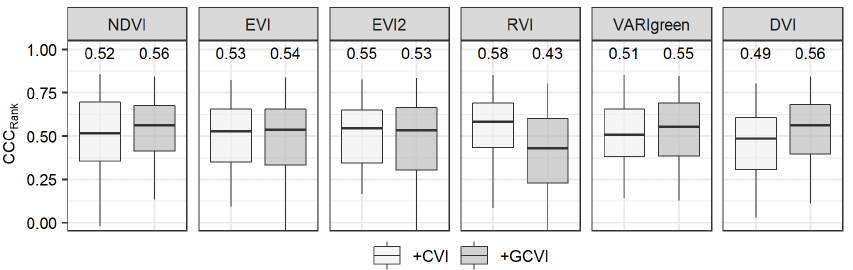
Figure A2. The concordance correlation coefficients of ranks for models with two vegetation indices in the post-peak stage. Values show the median CCC Rank . For better visualisation, the figure excludes negative CCC Rank.